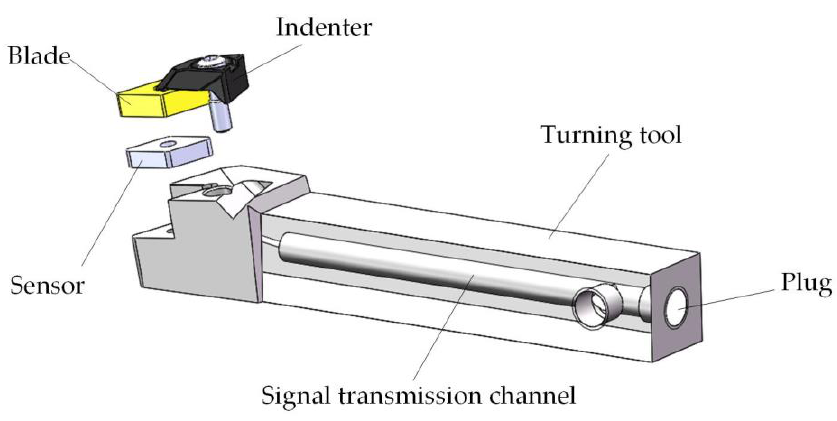
Figure 5. The structure of the smart tool.